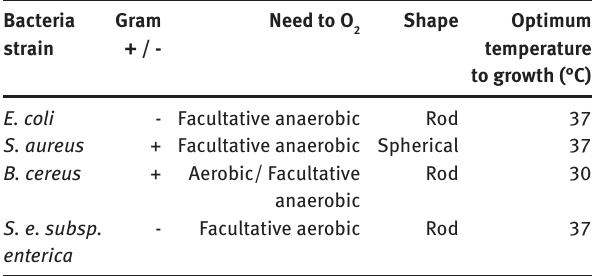
Table 1: Specifications of four studied bacteria strains.